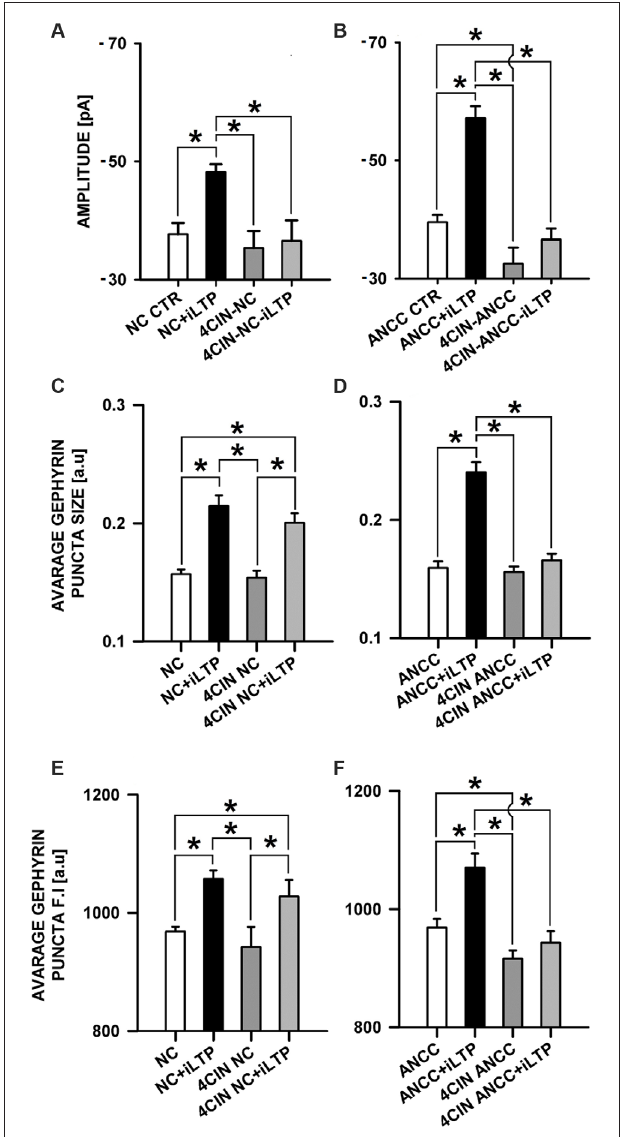
FIGURE 5 | Inhibition of astrocytic Krebs cycle by FA differentially affects iLTP in NC and ANCC. FA abolishes astrocyte effect on iLTP in ANCC. (A) Average mIPSC amplitude in NC, (B) average mIPSC amplitude in ANCC, (C) average gephyrin puncta size in NC, (D) average gephyrin puncta size in ANCC, (E) average gephyrin puncta fluorescence intensity in NC, (F) average gephyrin puncta fluorescence intensity in ANCC. Control group (white bar), NMDA stimulated group (black bar), FA treated group (dark gray), FA treated prior to iLTP induction group (gray bar). Star mark represent statistical significant data ( p < 0.05).